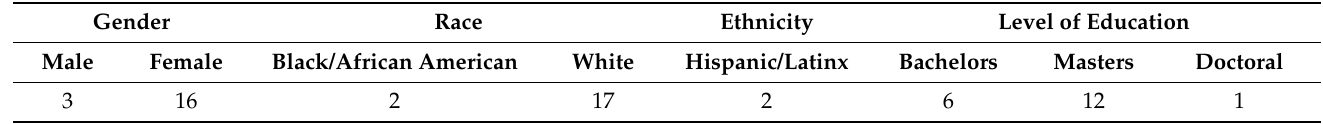
Table 2. Participant demographics.